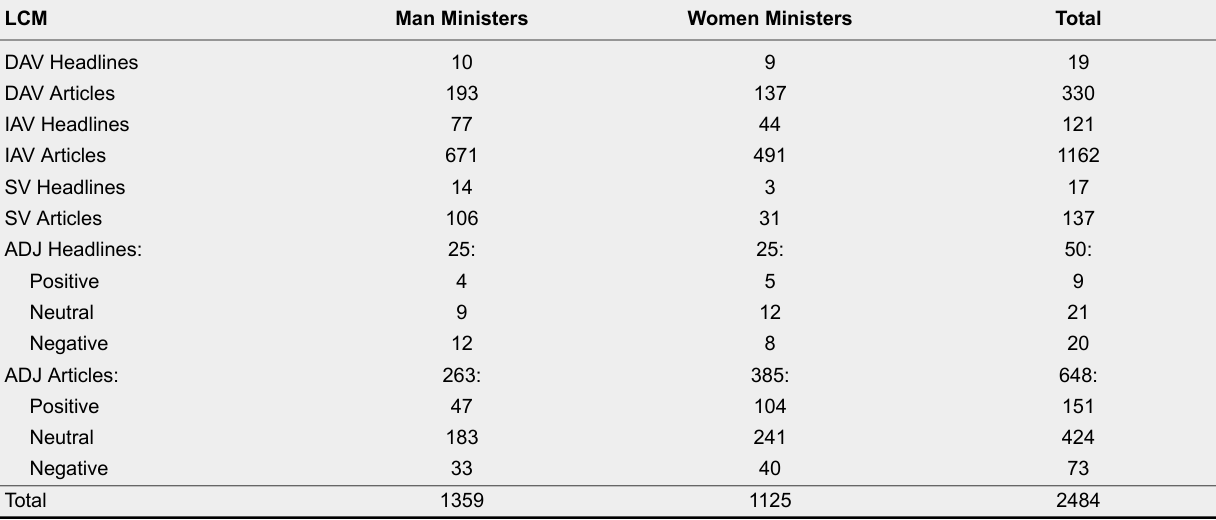
Frequency Distribution for the LCM Detected in Headlines and in Articles for Men and Women Ministers